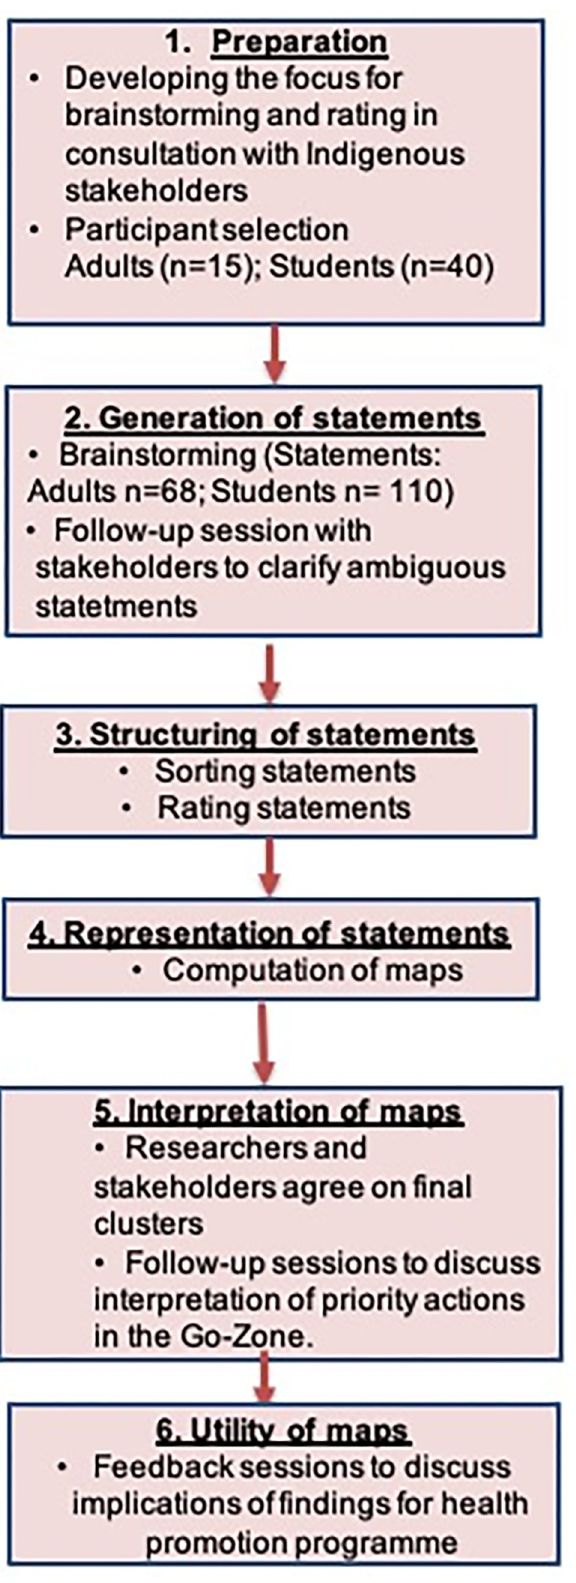
Fig 1. The concept mapping